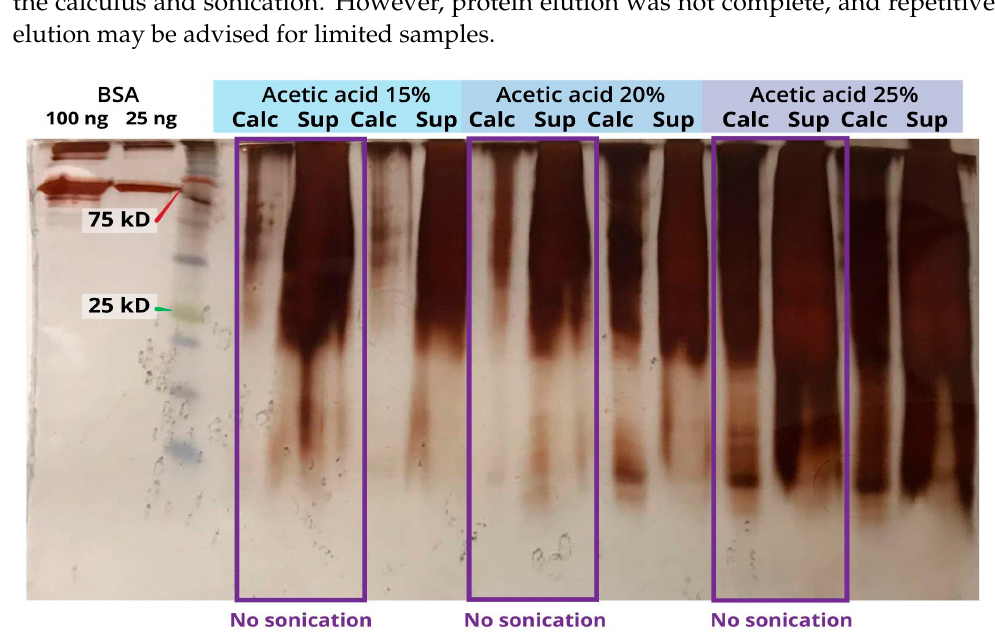
Figure 1. Silver-staining estimate of protein yield under different conditions. Calc.—calculus.